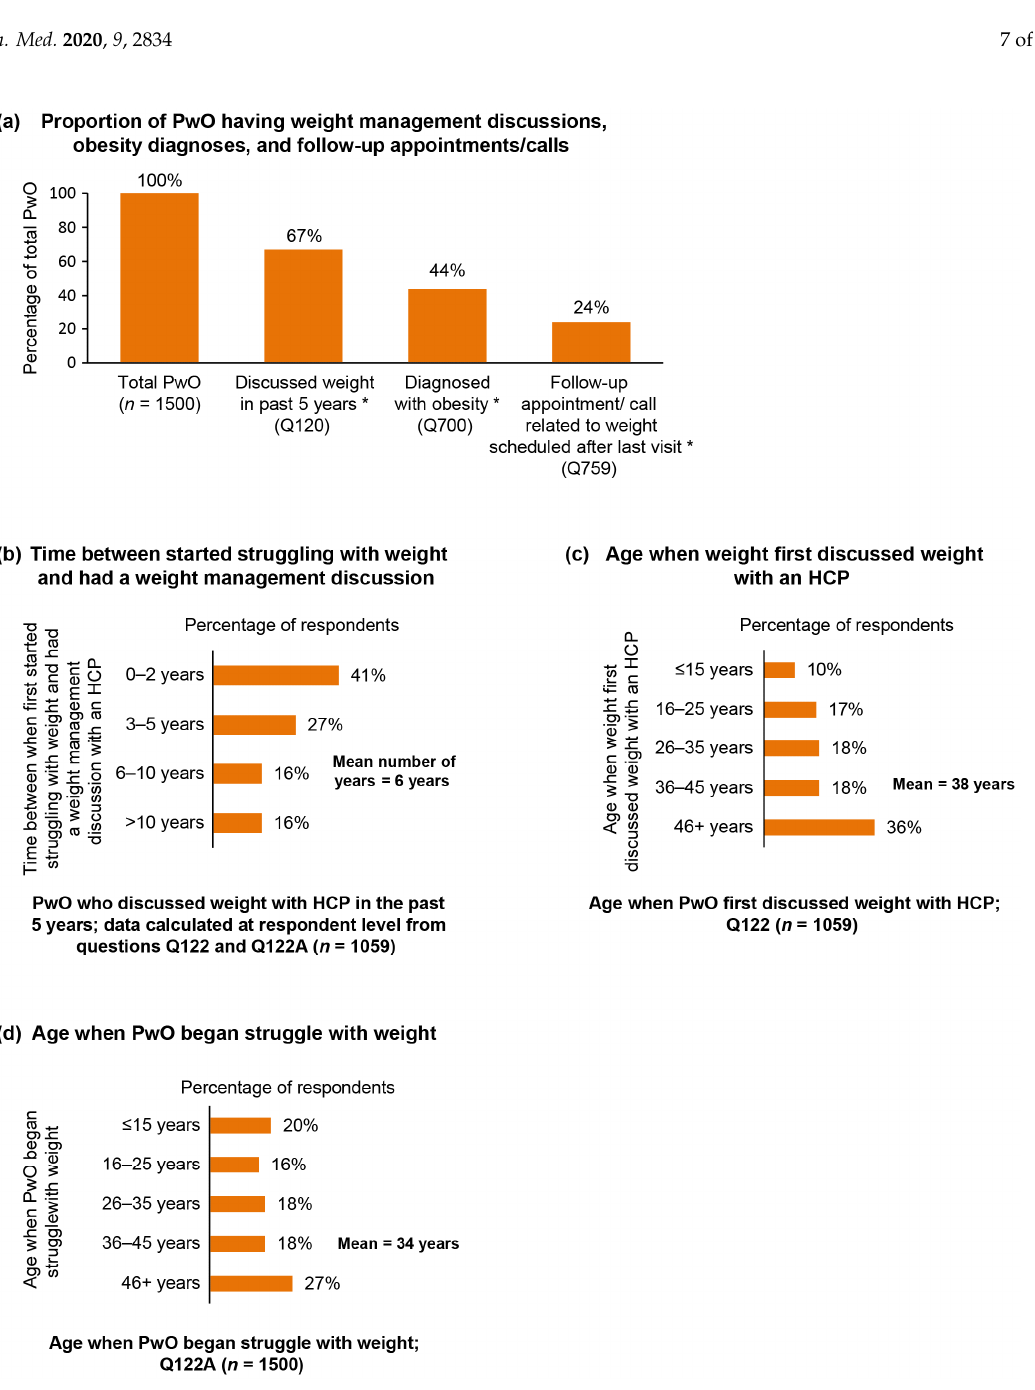
Figure 3. Weight management conversations and outcomes. ( a ) The proportion of PwO who have had weight management discussions with an HCP, obesity diagnoses, and follow-up appointments / calls; ( b ) time gap between first struggling with weight and having a weight management discussion with an HCP; ( c ) the age when PwO first discussed their weight with an HCP; ( d ) the age when PwO began their struggle with weight. * Percentage results are based on the total number of Spanish PwO ( n = 1500). HCP, healthcare professional; PwO, people with obesity.